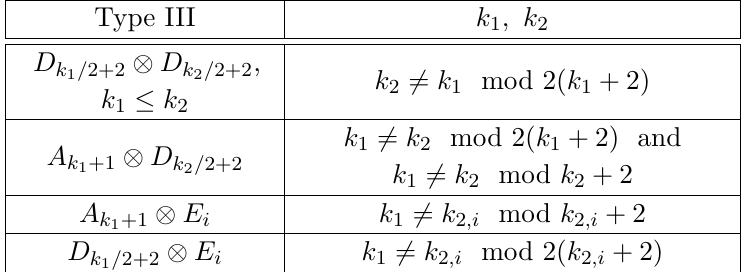
Table 4 . Theories which have neither slow growth nor single-trace twisted operators with two minimal models in the tensor product. For i = 6 , 7 , 8 one has k